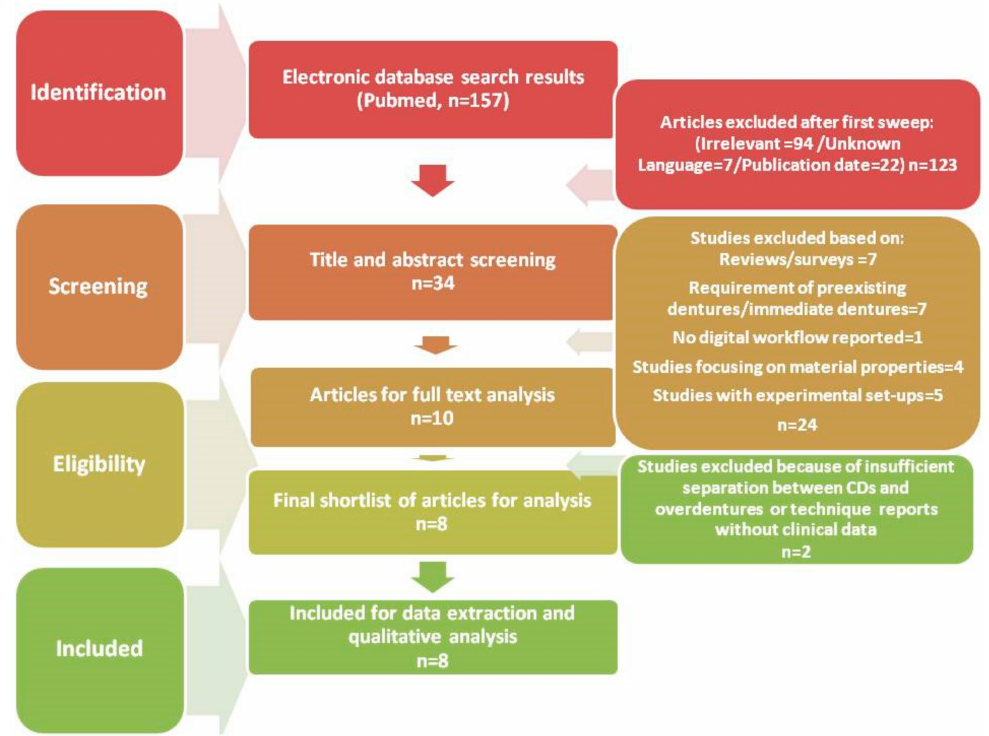
Figure 1. PRISMA flow diagram showing the identification, screening, eligibility and inclusion process of the studies (n: number).